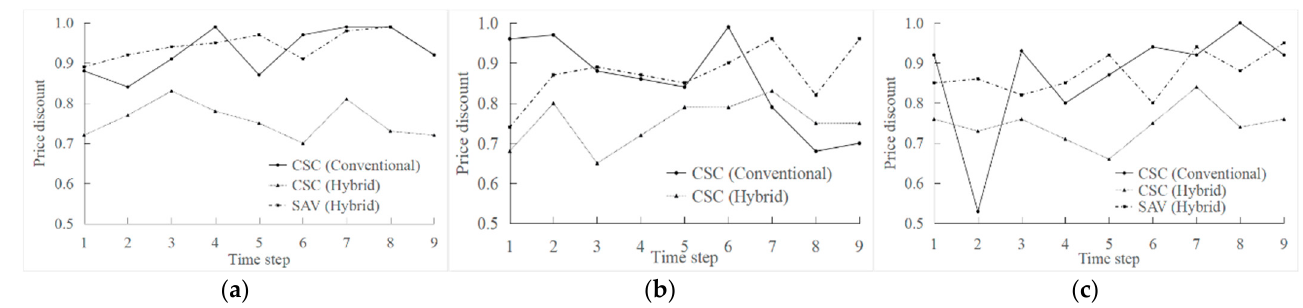
Figure 8. Price discount for each cluster in both carsharing systems. ( a ) Cluster 1, ( b ) Cluster 2, ( c ) Cluster 3.